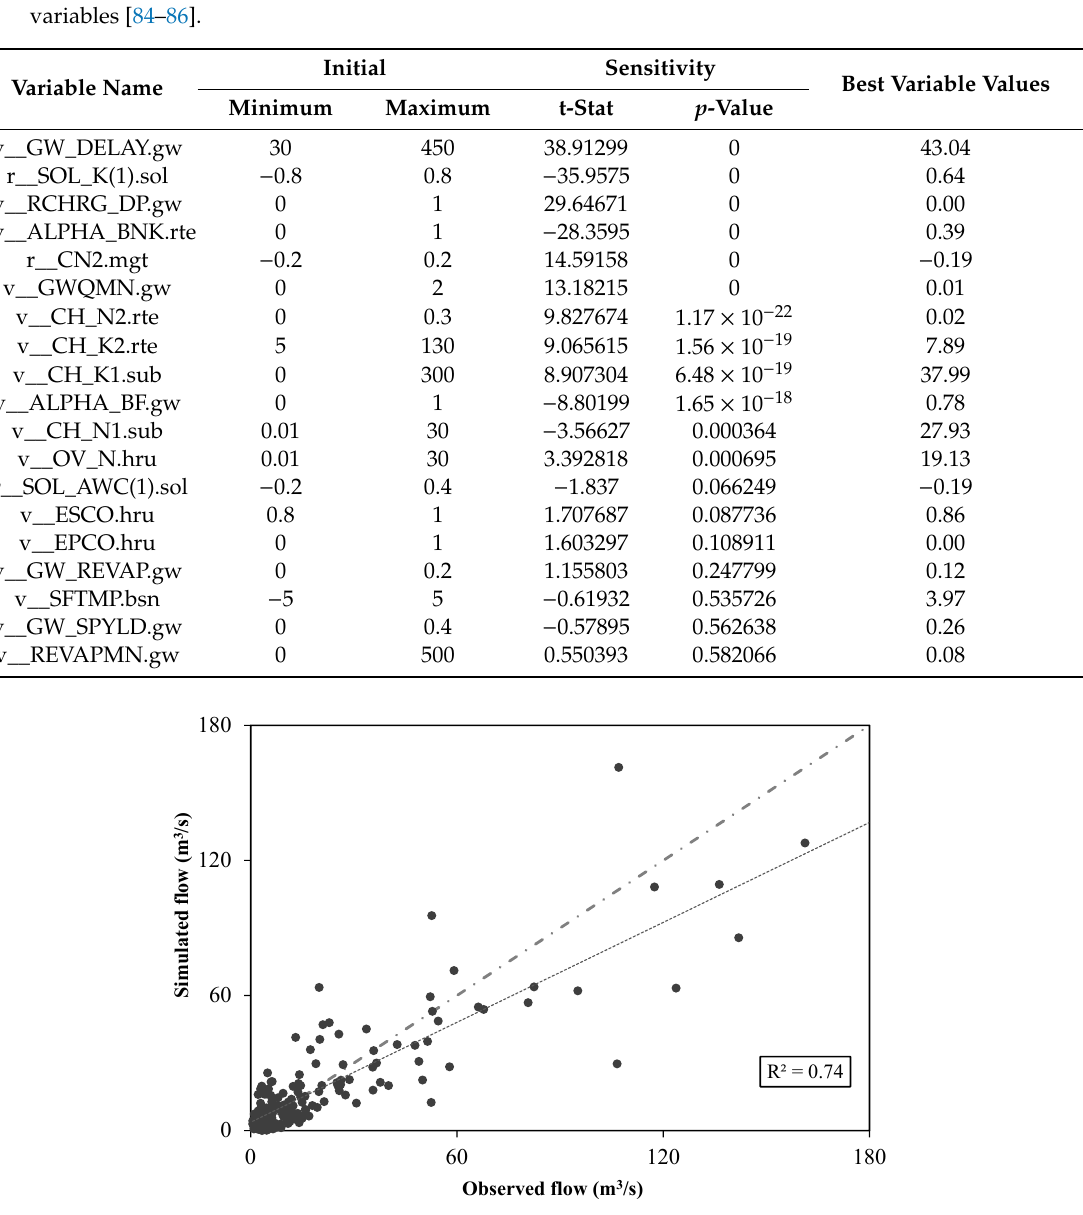
Figure 8. Simulated vs. observed flow in the Oum Er Rbia River at the Mechra Eddahk station.